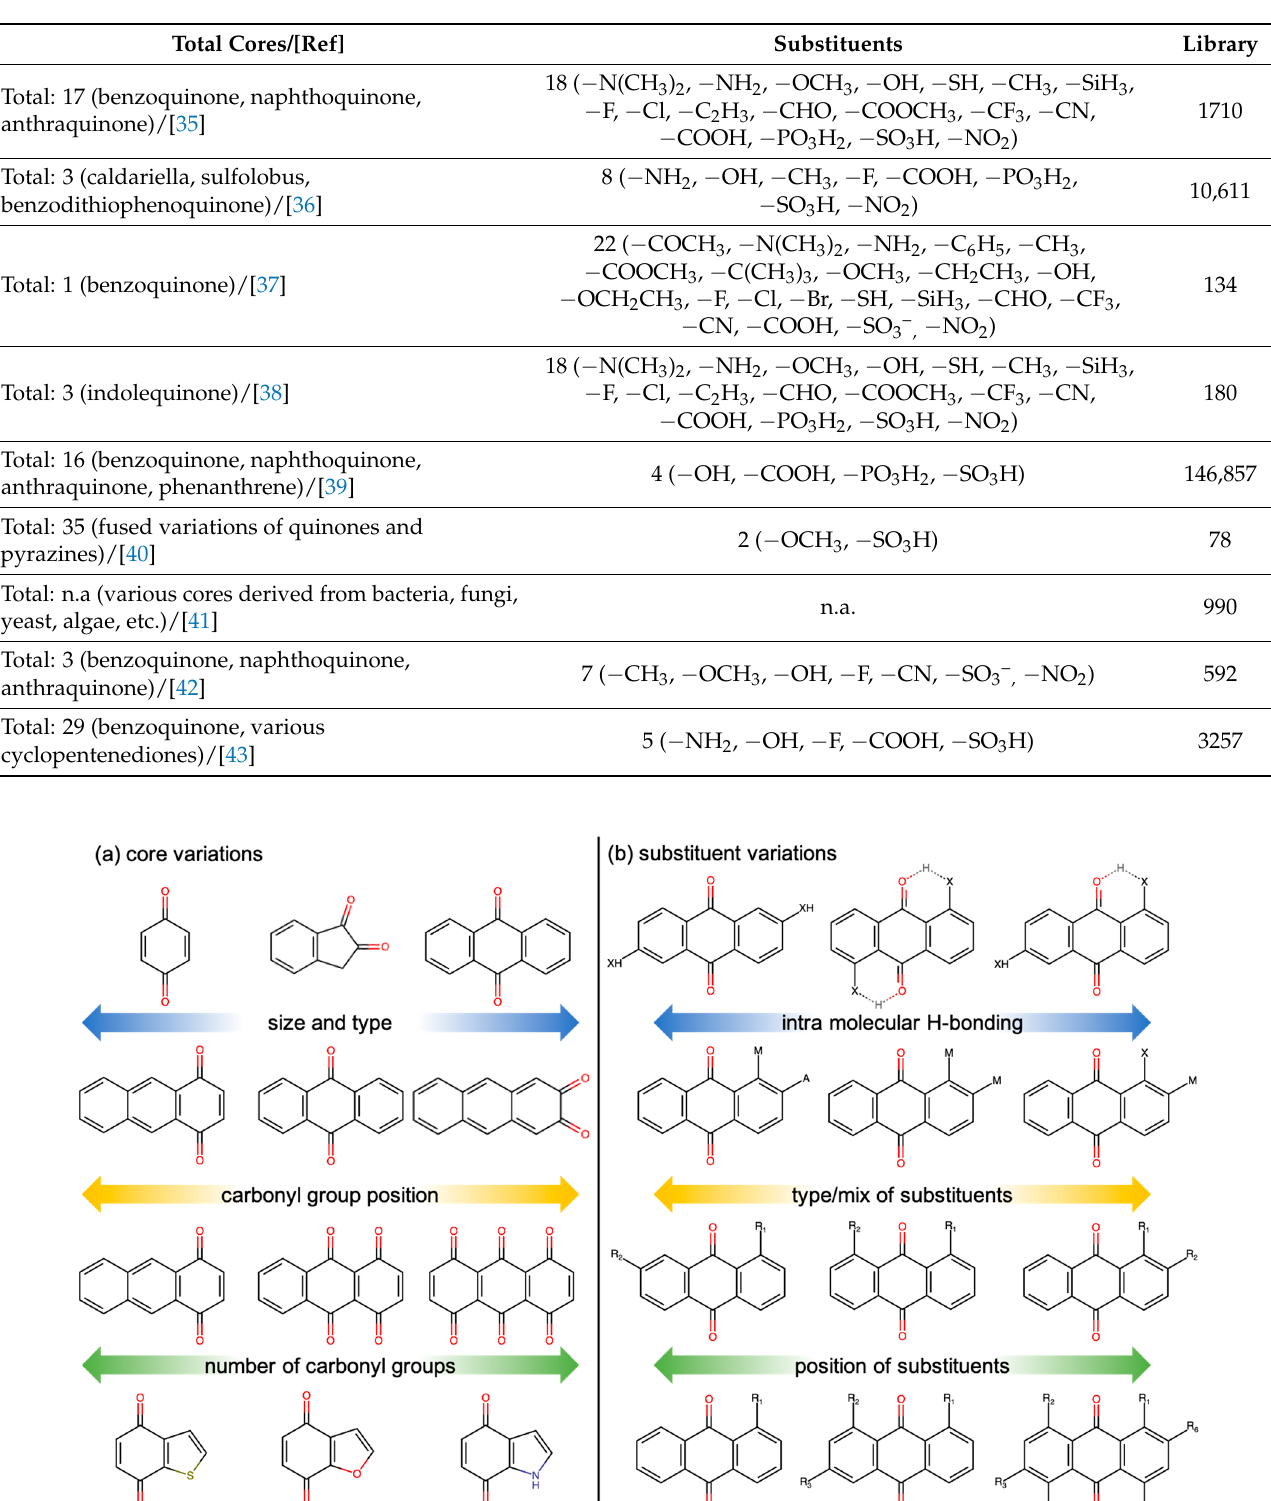
Table 3. Summary of the virtual libraries enumerated in HTVS literature for quinones.